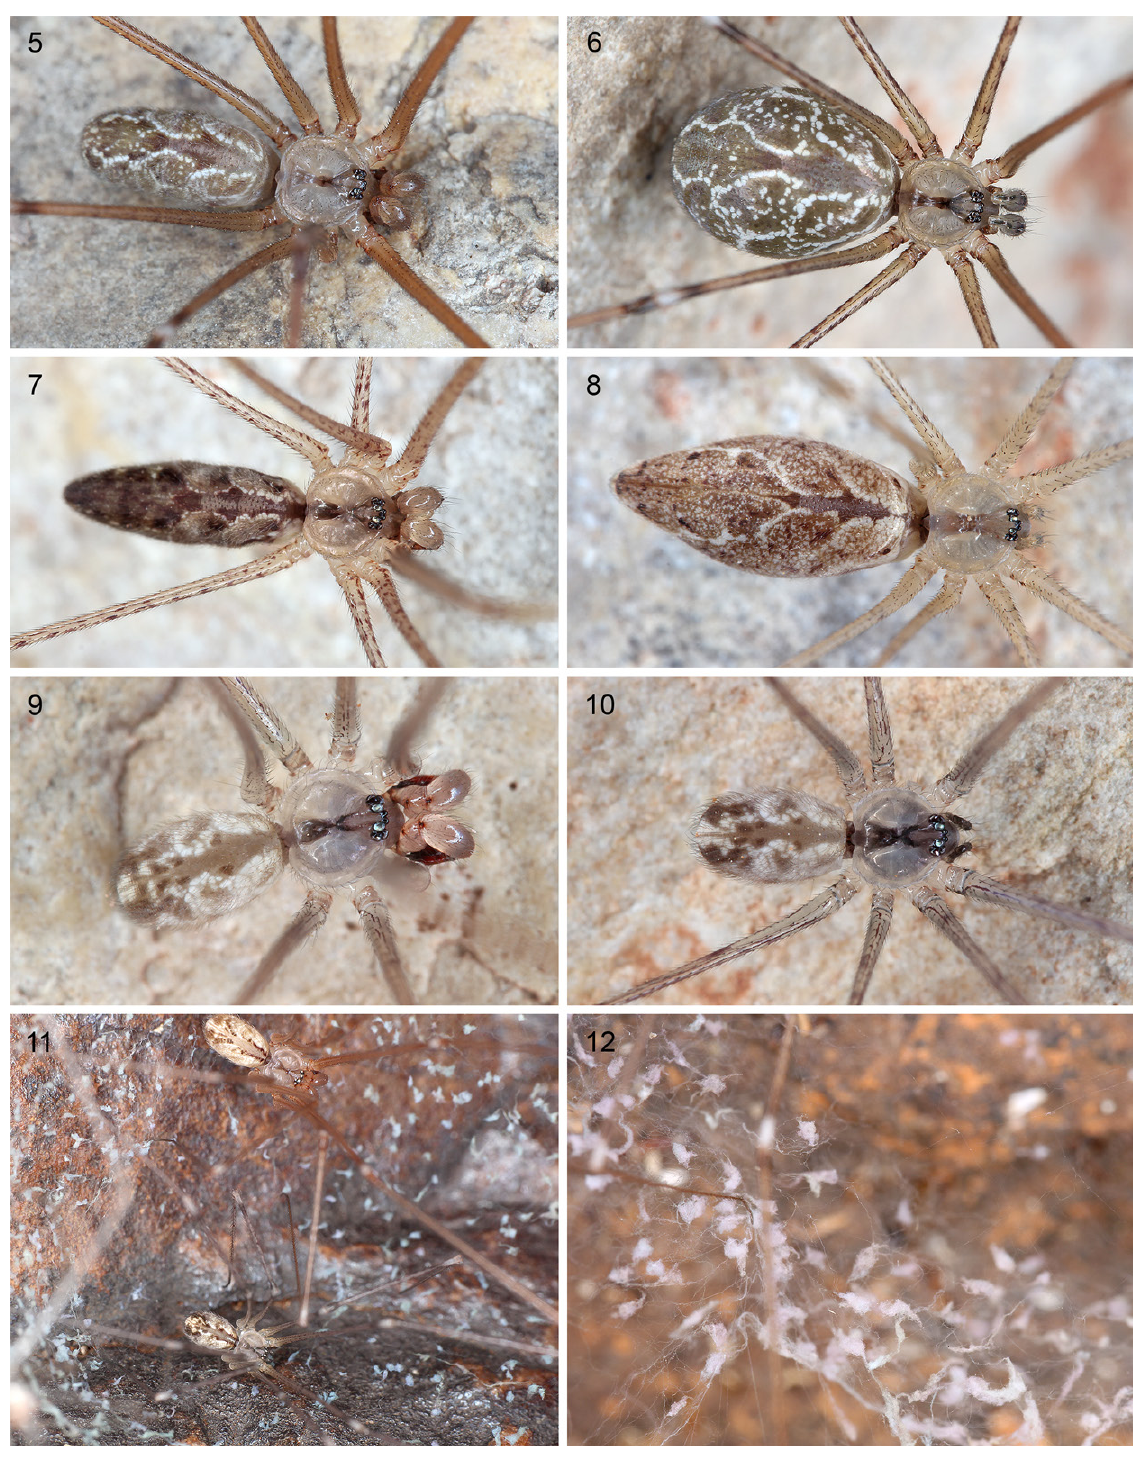
Figs 5–12. Live specimens and webs. 5–6 . Holocnemus pluchei (Scopoli, 1763); male and female from Morocco, Imi n’Ifri. 7–8 . Holocnemus reini (C. Koch, 1873) comb. nov.; male from Morocco,